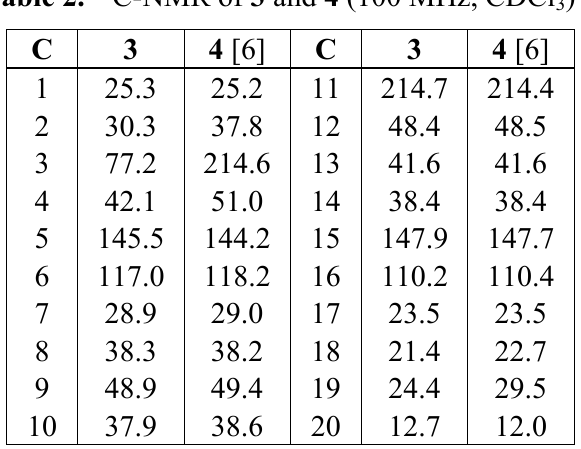
Table 2. 13 C-NMR of 3 and 4 (100 MHz, CDCl